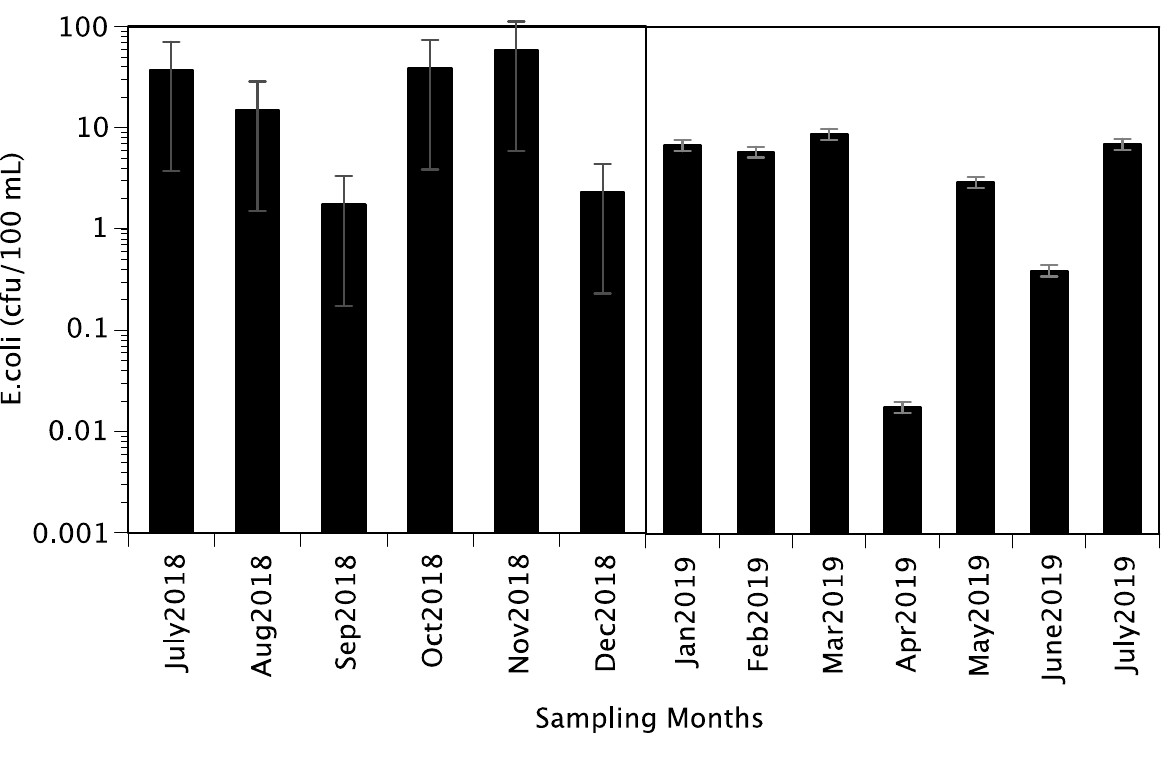
Figure 4. Average values of E. coli of raw water (n = 390).